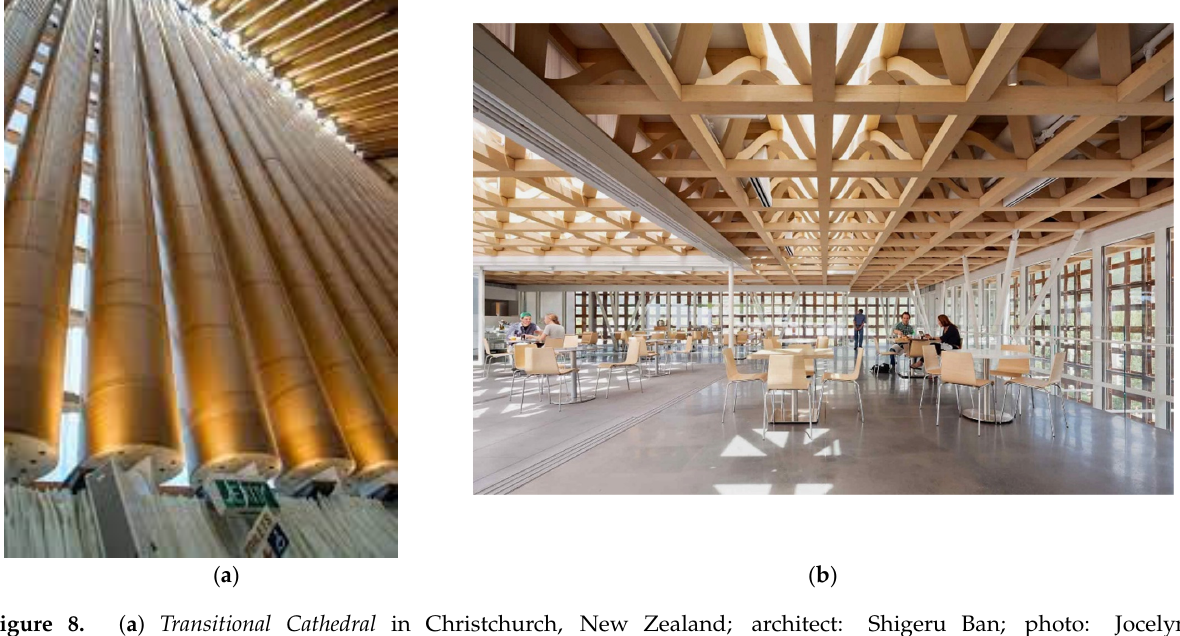
Figure 8. ( a ) Transitional Cathedral in Christchurch, New Zealand; architect: Shigeru Ban; photo: Jocelyn Kinghorn; source: Wikimedia Commons; ( b ) Aspen Art Museum (2012–2014); photo: Michael Moran/OTTO; source: https://www.arch- daily.com/546446/aspen-art-museum-shigeru-ban-architects/540f87e0c07a803fb300003e-aspen-art-museum-shigeru-ban- architects-photo (accessed on 5 May